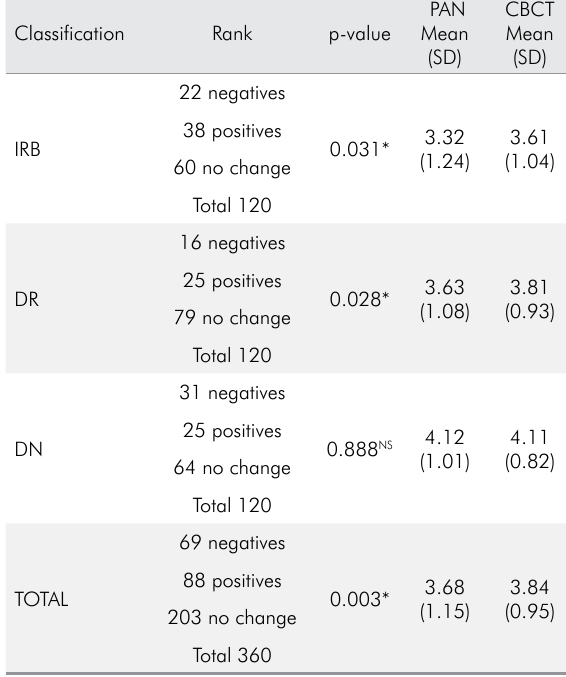
Table 2. Score ranking for the question “How confident are you in the diagnosis of this clinical case?” A negative rank indicates the confidence score was higher when the panoramic exam was available, while a positive rank means higher diagnostic confidence after CBCT.